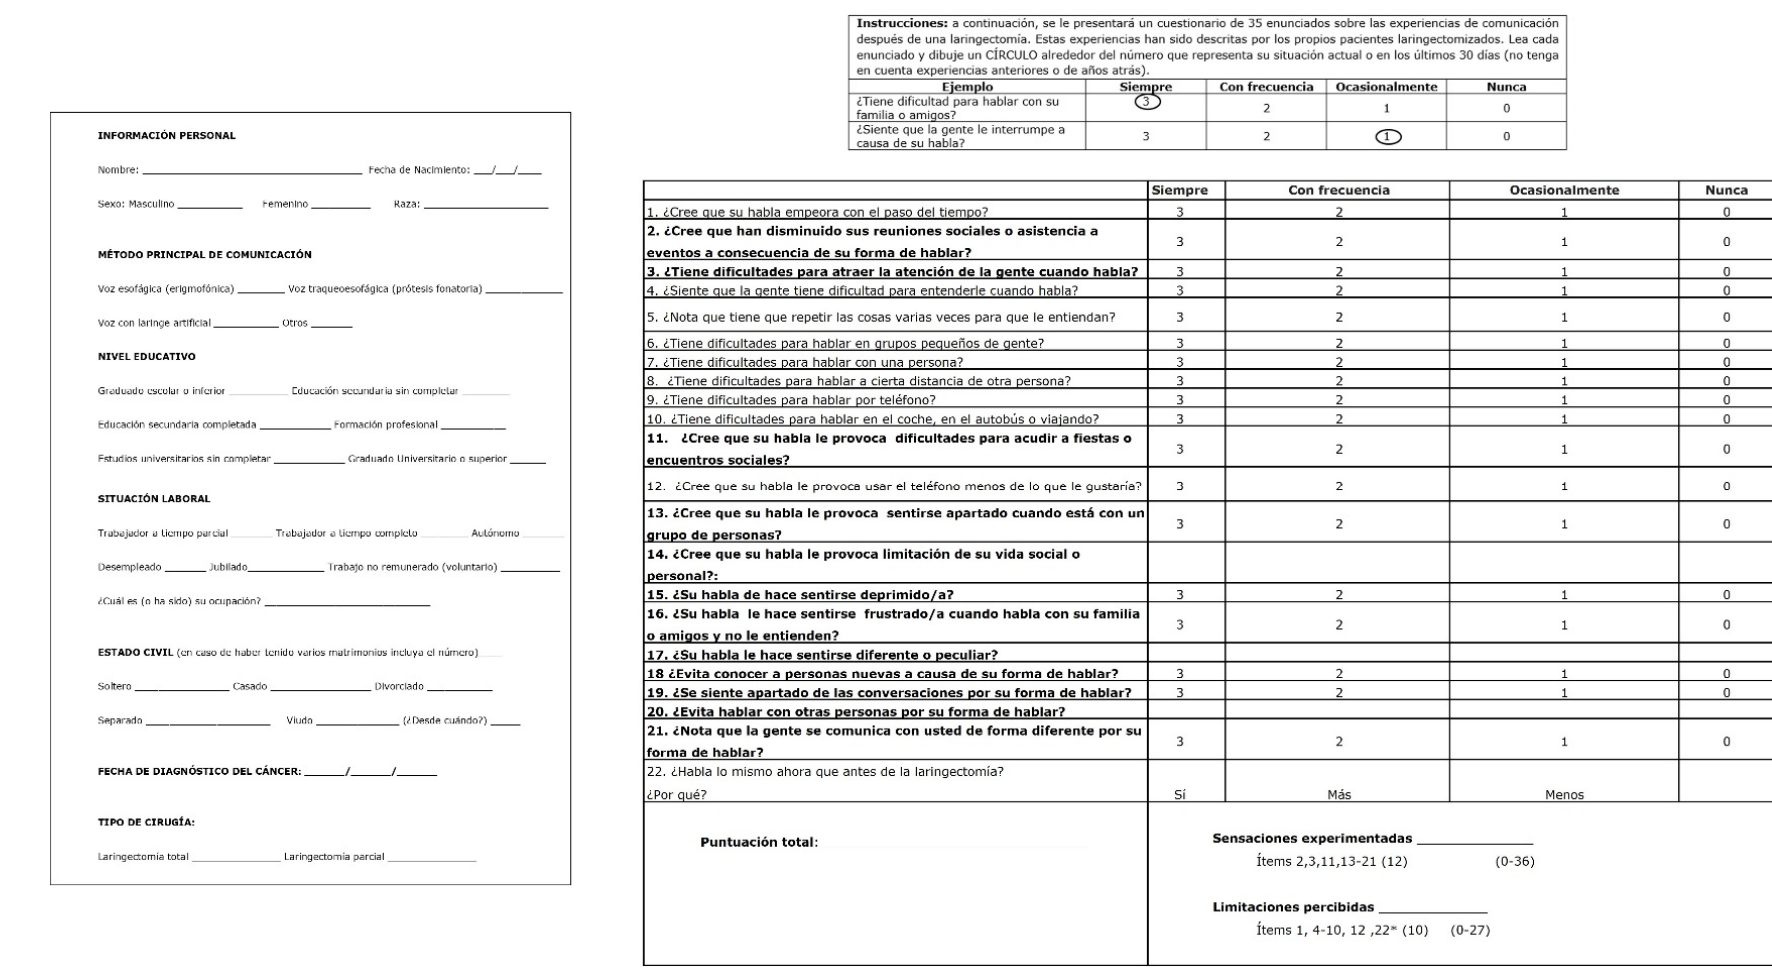
Figure 1. Self ‐ Evaluation of Communication Experiences after Laryngectomy–Spanish adaptation (S ‐ SECEL). Figure 1. Self-Evaluation of Communication Experiences after Laryngectomy–Spanish adaptation